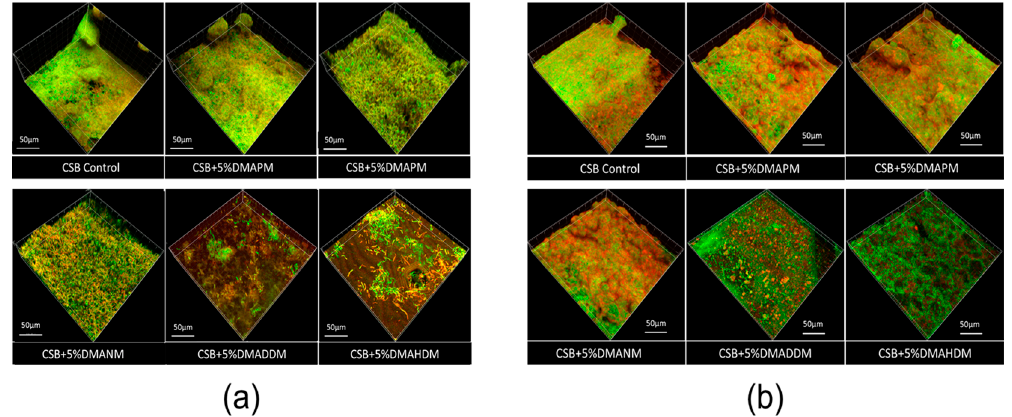
Figure 6. Confocal laser scanning microscope (CLSM) of three-species biofilms. ( a ) Live/dead staining of biofilms on the adhesive disks of the six groups. Bacterial cells were stained green, and dead cells were stained red; ( b ) exopolysaccharide (EPS) staining of biofilms on the adhesive disks of the six groups. Bacteria were stained green, and EPS was stained red.